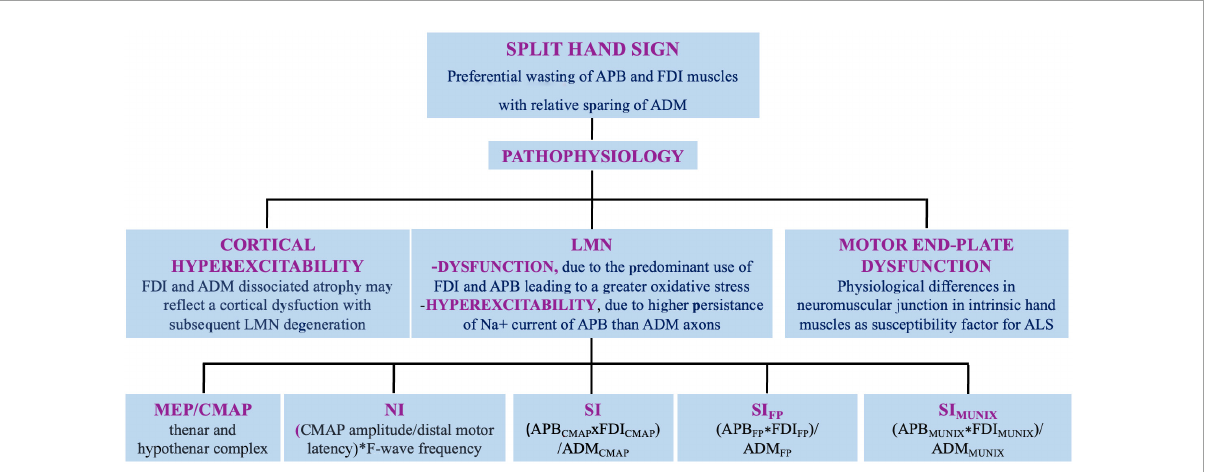
FIGURE1 Split hand sign in ALS: definition, pathophysiology, and neurophysiologic indexes. APB, abductor pollicis brevis muscle; FDI, first dorsal interosseus; ADM, abductor digiti minimi muscle; LMN, lower motor neuron; MEP, motor evoked potential; CMAP, compound muscle action potential; NI, neurophysiological index; SI, split hand index; SIFP, SI derived from F-waves; SIMUNIX, SI based on MUNIX software.